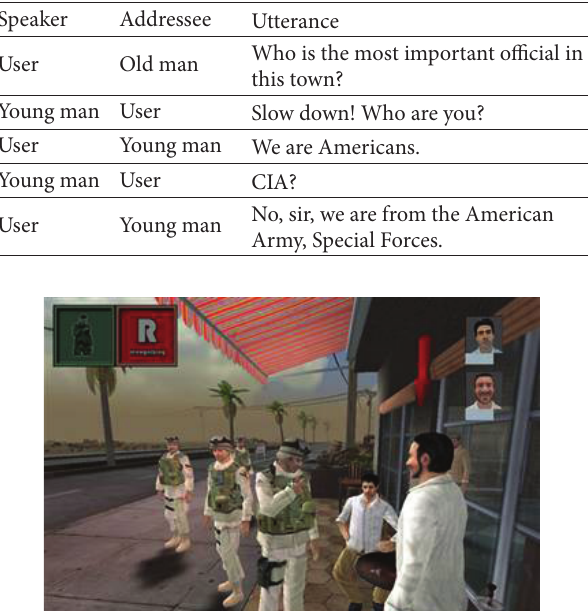
Table 1: Sample Dialogue in Tactical Language Training System.